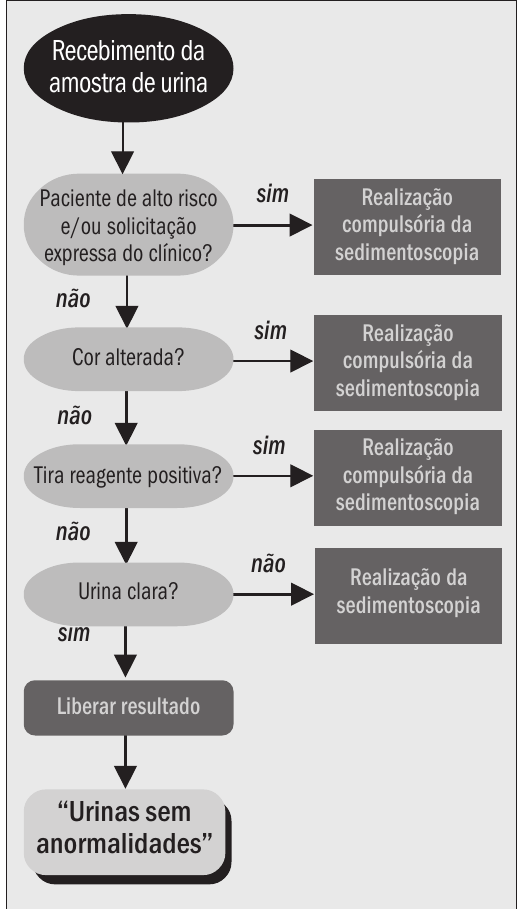
Figura – Fluxograma de urinálise. Adaptado de Christenson, R.H. et